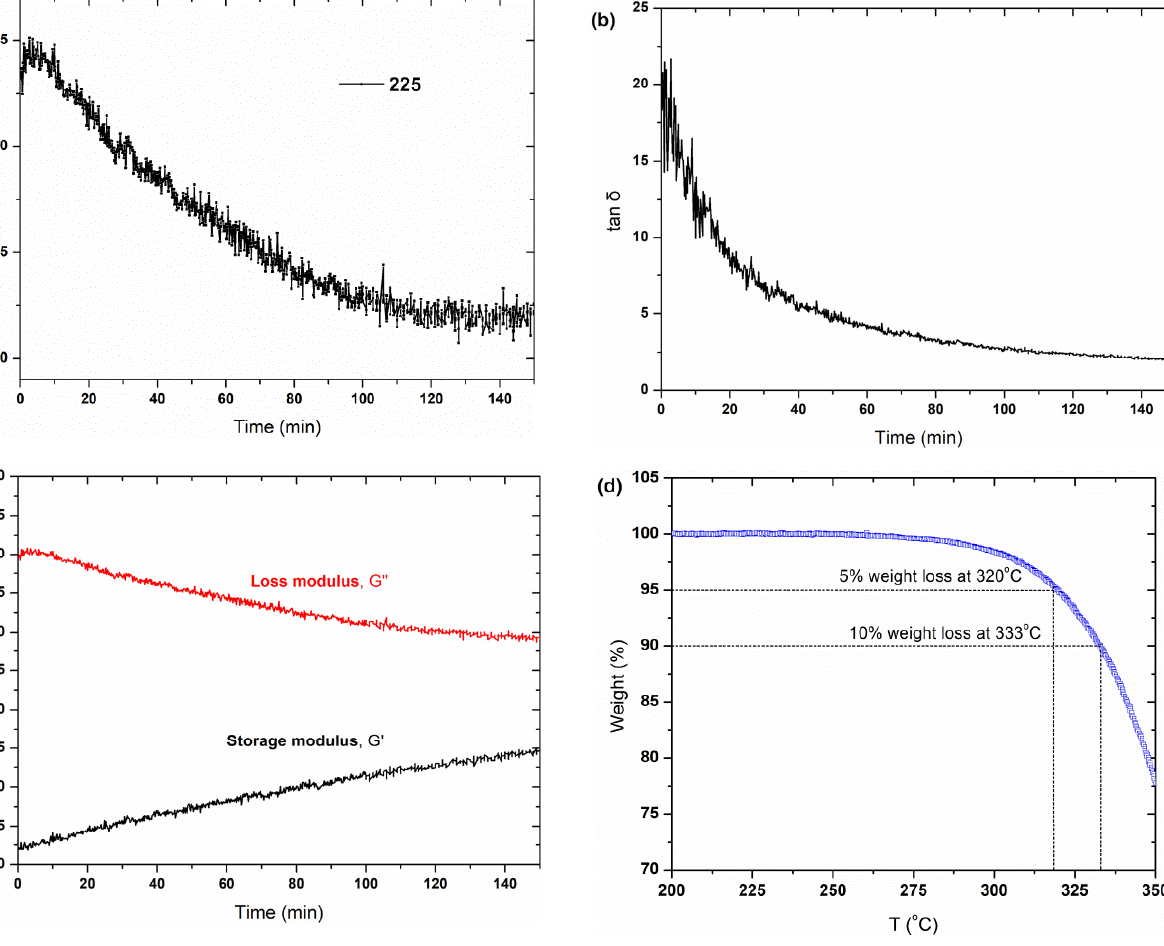
Figure 6. Measurements of the thermal stability of pristine PGA: ( a – c ) isothermal shear behavior under 10 rad s − 1 and ( d ) TGA analysis within 200–350 °C.